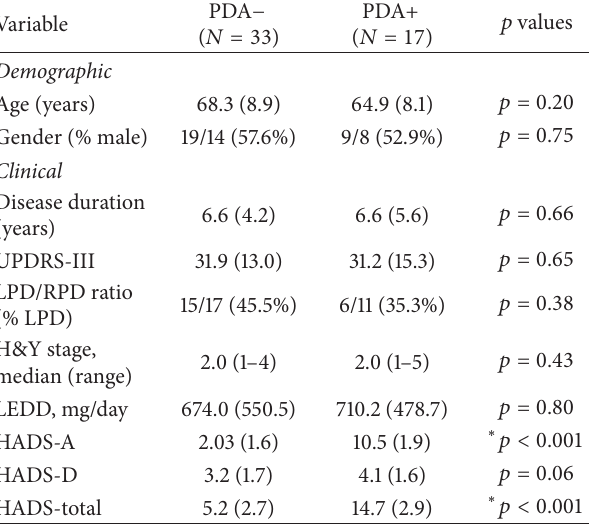
Table 1: Demographic and clinical variables in PD